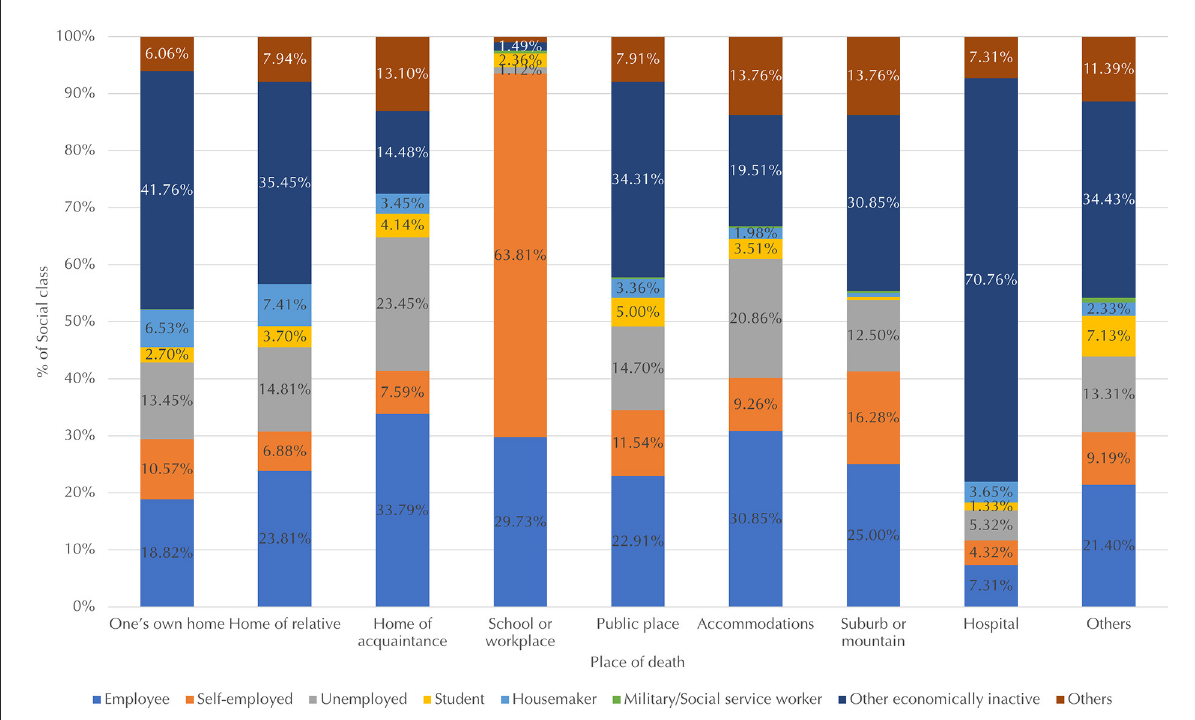
FIGURE4 Distribution of social classes (measured by employment status) across places of death. Data for social classes that accounted for < 1% of victims for place of death, including military or social service workers, are not shown due to limited